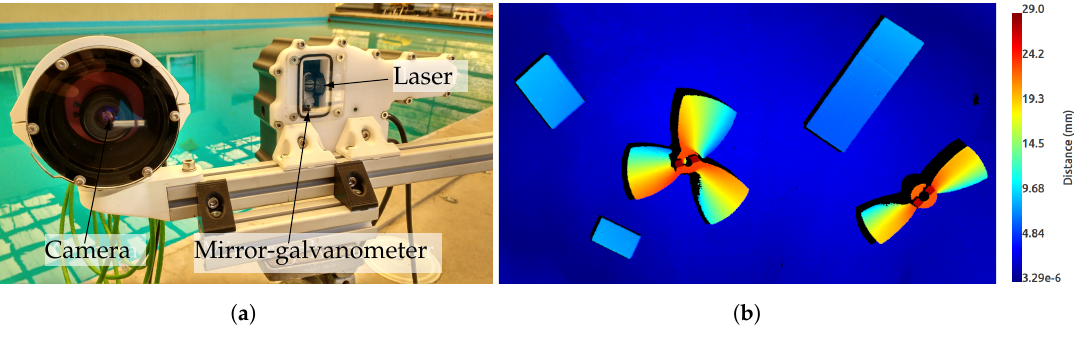
Figure 1. The laser scanner mounted on a tripod ( a ) and an example of the point cloud gathered with it coloured according to each point’s distance to the background ( b ).